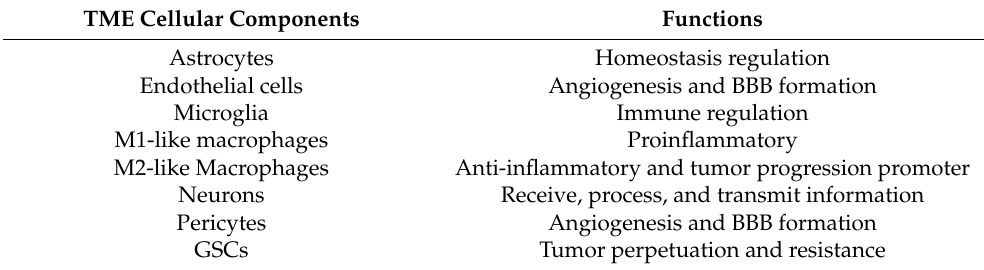
Table 1. Main functions of cellular components of TME of